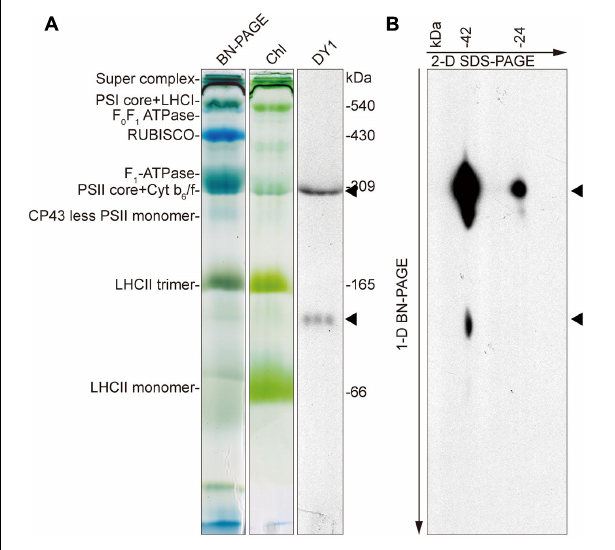
FIGURE 9 | Blue-native PAGE and Western blot showing that DY1 exists in different protein complexes in chloroplast. Protein samples of intact chloroplasts from 3-week-old wild-type Arabidopsis plants were separated by BN-PAGE as the first dimension (A) . Chl, gel after blotting which contains chlorophylls only. The gel was either directly blotted and probed with the anti-DY1 antibody or further separated by SDS–PAGE as the second dimension and then blotted and probed with the same antibody (B) . Positions of DY1 protein probed by its antibody were indicated by